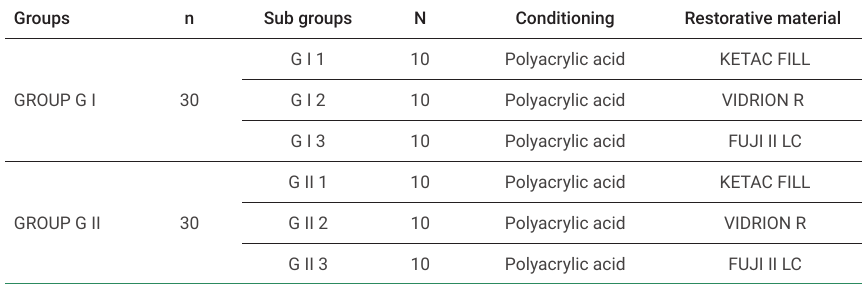
Table 2. Group distribution according to technique and restorative material used Groups